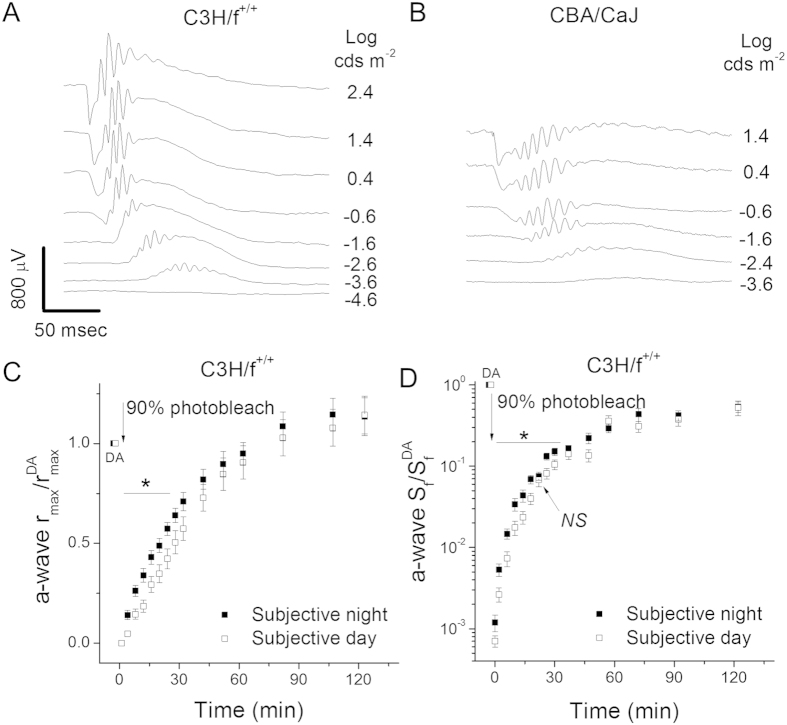
Effect of the circadian clock on rod dark adaptation in melatonin-proficient mice.(A) Representative dark-adapted scotopic in vivo ERG responses to various light intensities from melatonin-proficient C3H/f+/+ mice. (B) Representative dark-adapted scotopic in vivo ERG responses from melatonin-proficient CBA/CaJ mice revealing b-wave deficit. (C) Normalized in vivo ERG scotopic a-wave maximal response (a-wave rmax/rDAmax) recovery in C3H/f+/+ mice following 90% pigment bleach at t = 0 at subjective night (solid squares, n = 15) and subjective day (open squares, n = 16) (*p < 0.05). (D) Normalized in vivo ERG scotopic a-wave sensitivity (a-wave Sf/a-wave SfDA) recovery in C3H/f+/+ mice following 90% pigment bleach at t = 0 at subjective night (solid squares, n = 15) and subjective day (open squares, n = 16) (*p < 0.05). Here and in all subsequent figures, DA refers to the initial dark-adapted value of the a-wave maximal response or sensitivity.